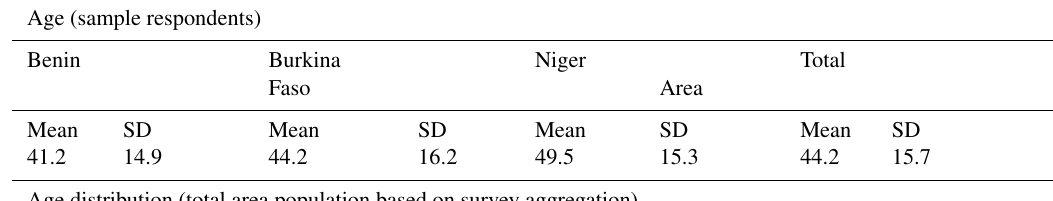
Table 2. Socioeconomic characteristics of the surveyed